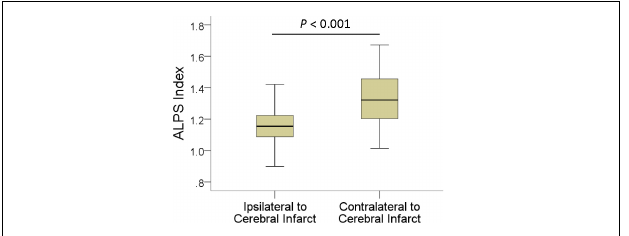
FIGURE 2 | Boxplot shows interhemispheric differences in the ALPS index.